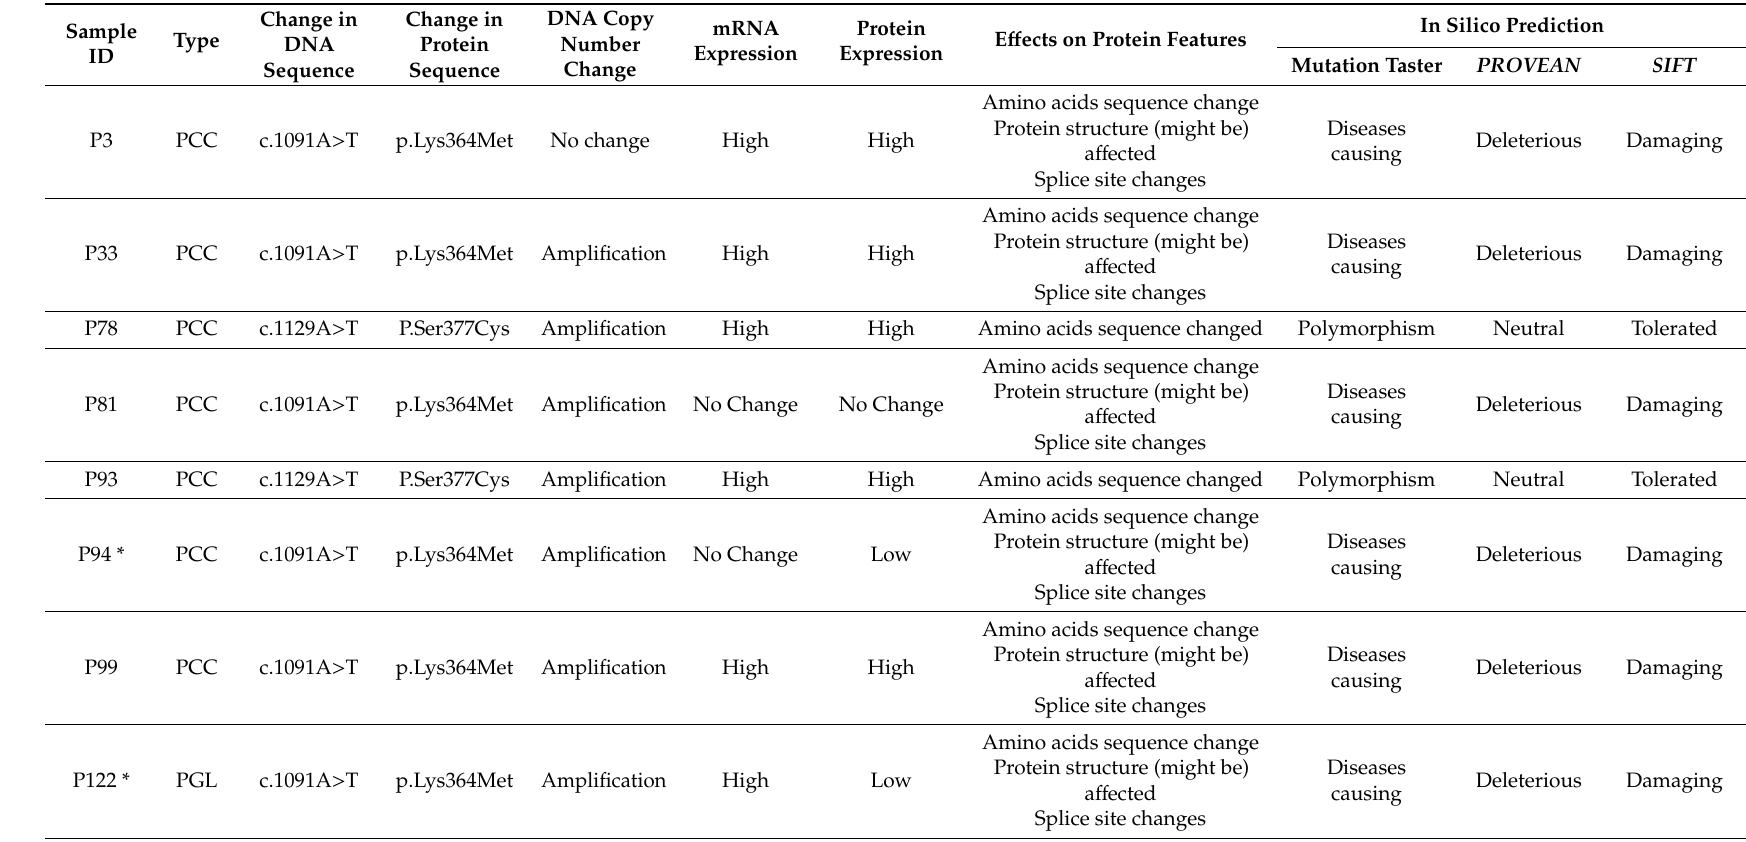
Table 1. Mutations detected in the sequence of EPAS1 in phaeochromocytoma (PCC) / paraganglioma (PGL).